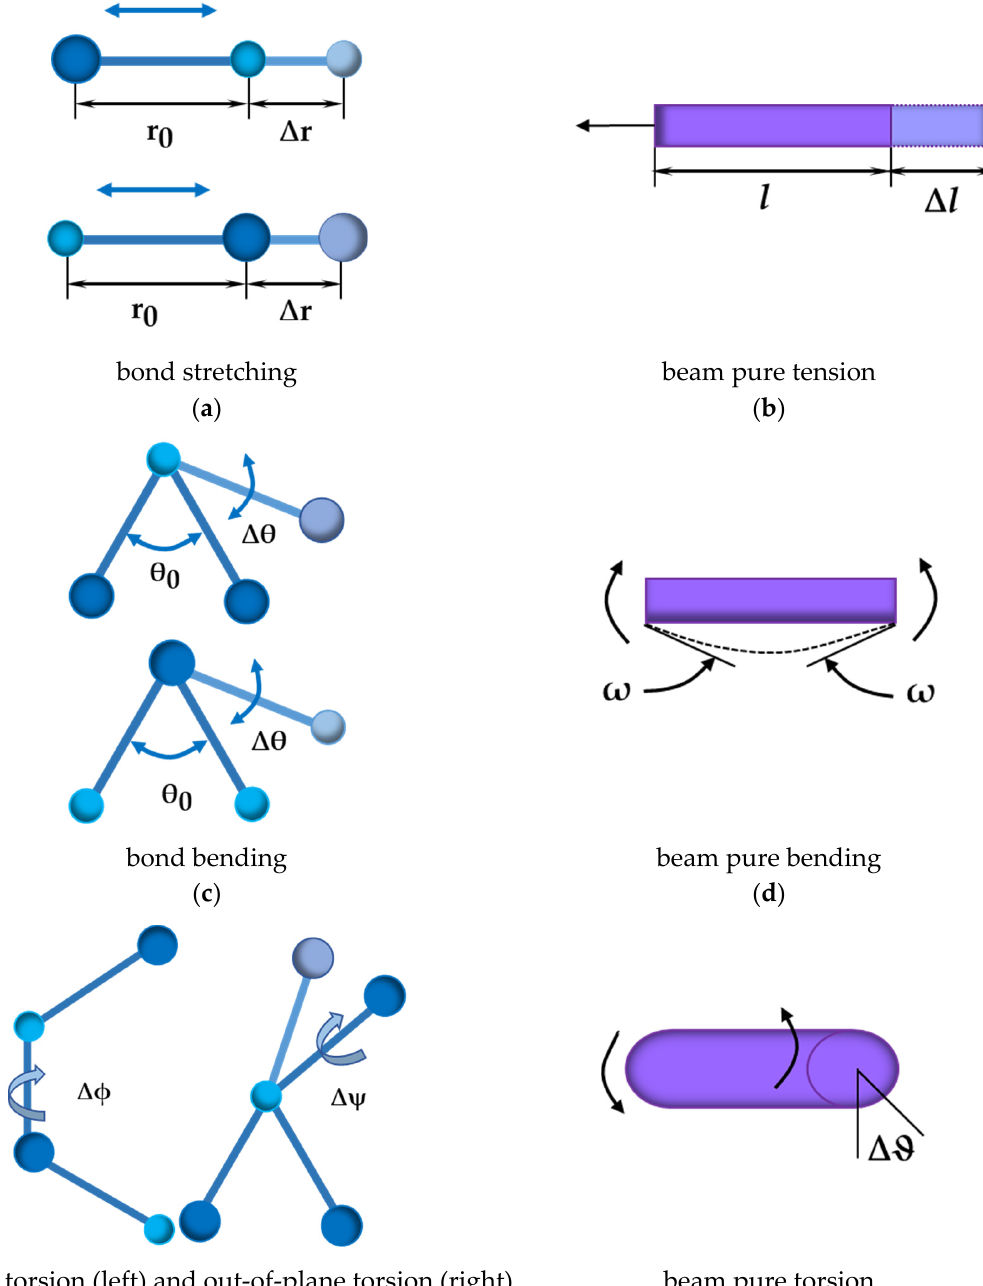
Figure 3. Equivalence between InN nanostructure bonding interactions and beam elements: ( a ) bond stretching; ( b ) pure tension of the beam; ( c ) bond bending; ( d ) pure bending of the beam; ( e ) dihedral torsion (right) and out-of-plane torsion or inversion (left); ( f ) pure torsion of the beam. In atoms are shown in bright blue; N atoms in pale blue.